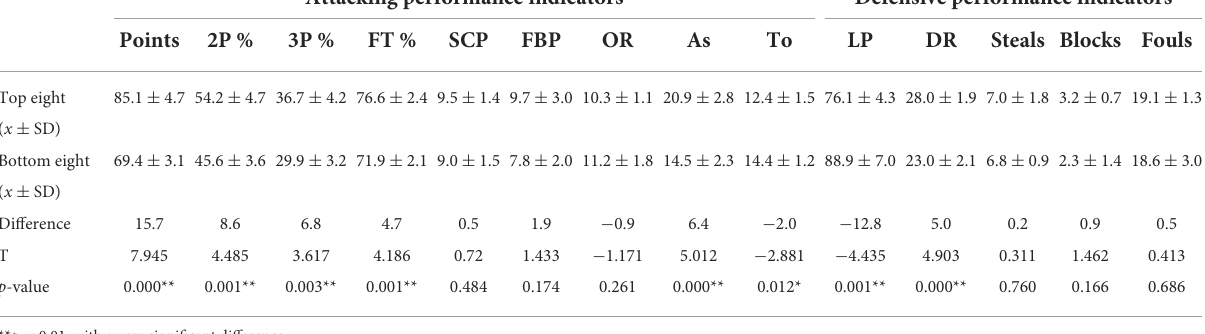
The Spearman Rho correlation analysis was performed at the 0.05 confidence level to test the relationship between the RSR of attack, defense, and the overall attack-defense and the final rankings, respectively. The attack RSR, defense RSR and